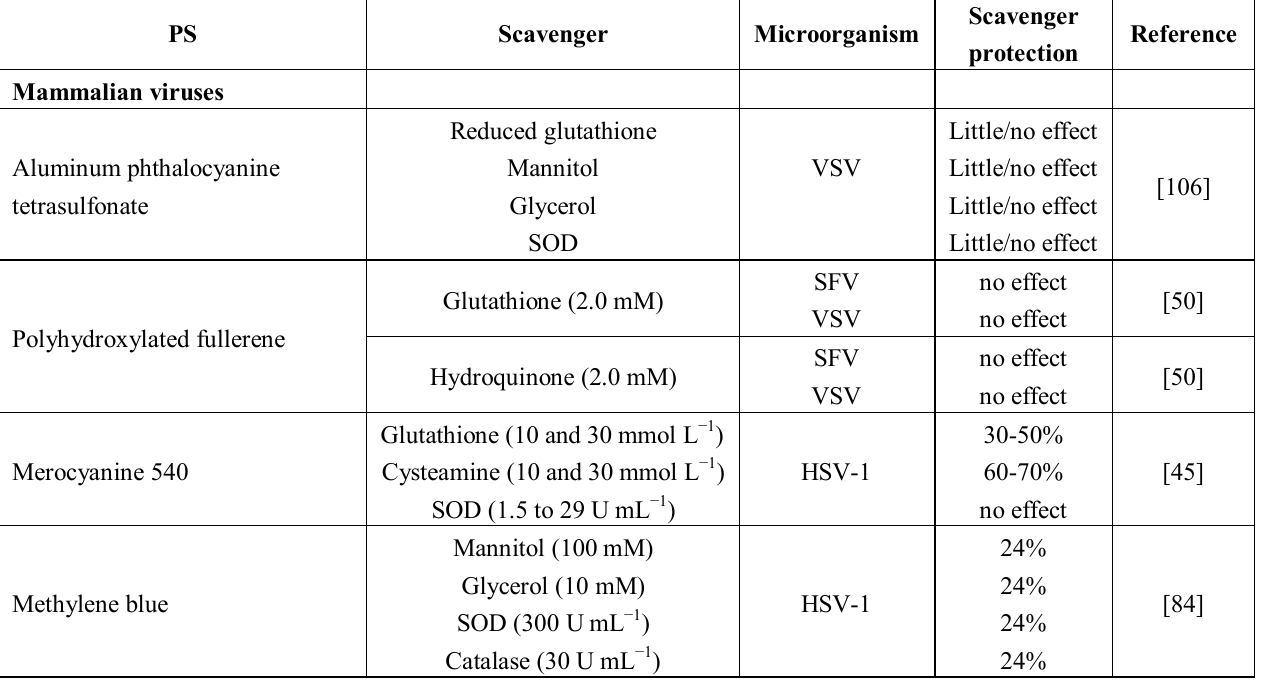
Table 2. Free radical scavengers used in mammalian viruses and bacteriophages PDI.